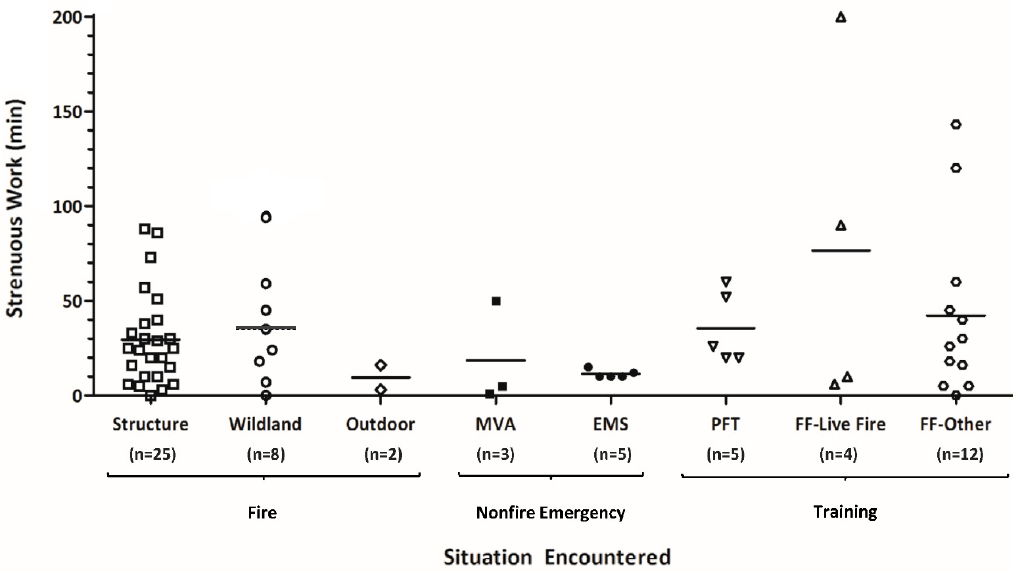
Figure 2. Distribution of time (min) spent performing strenuous work on-scene prior to the onset of symptoms by situation encountered among cardiac fatalities investigated by NIOSH for incidents that occurred 9 January 2008–10 February 2017 (N = 64). MVA, motor vehicle accident; EMS, emergency medical services; PFT, physical fitness training; FF, firefighting. Solid lines represent the mean.